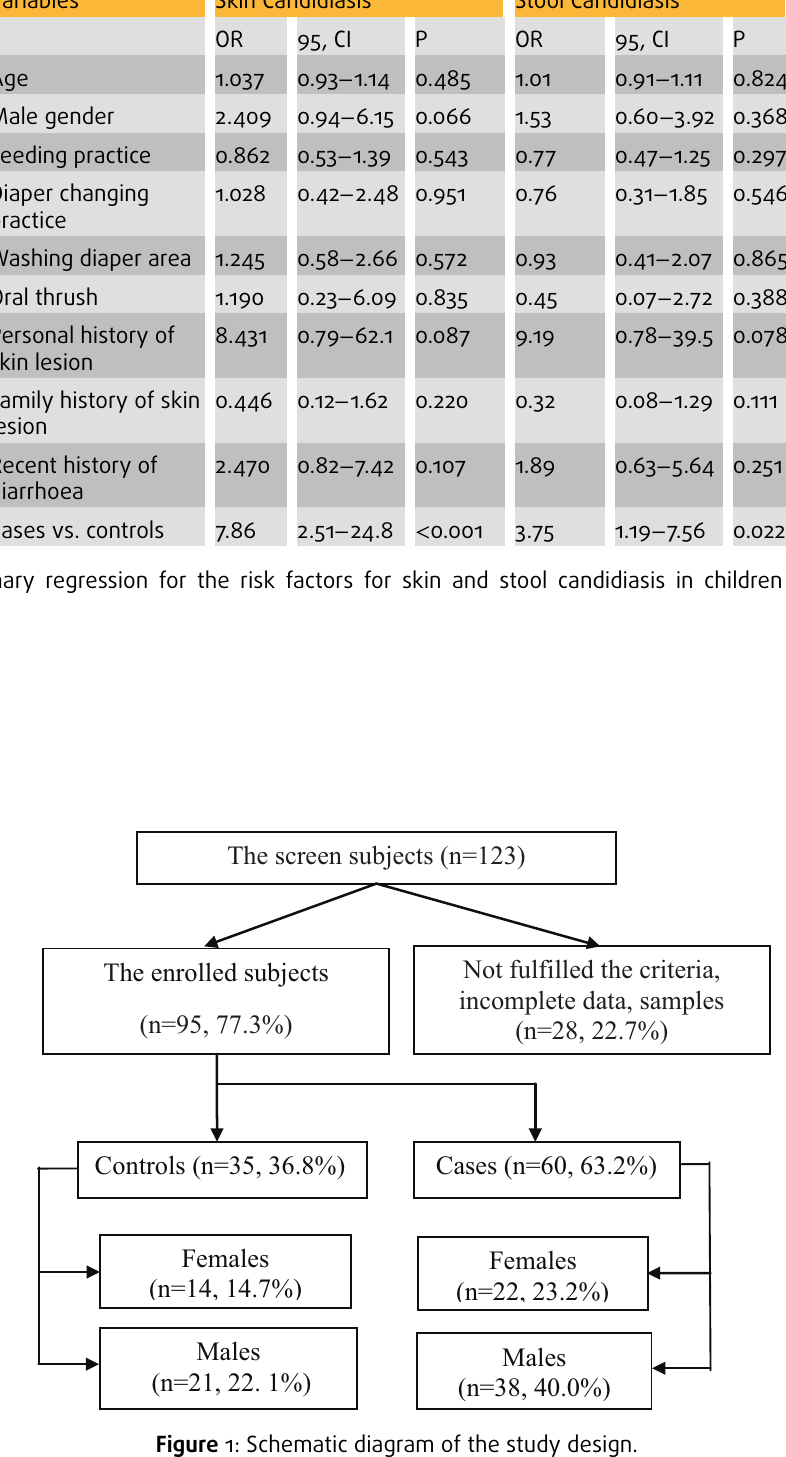
Figure 1: Schematic diagram of the study